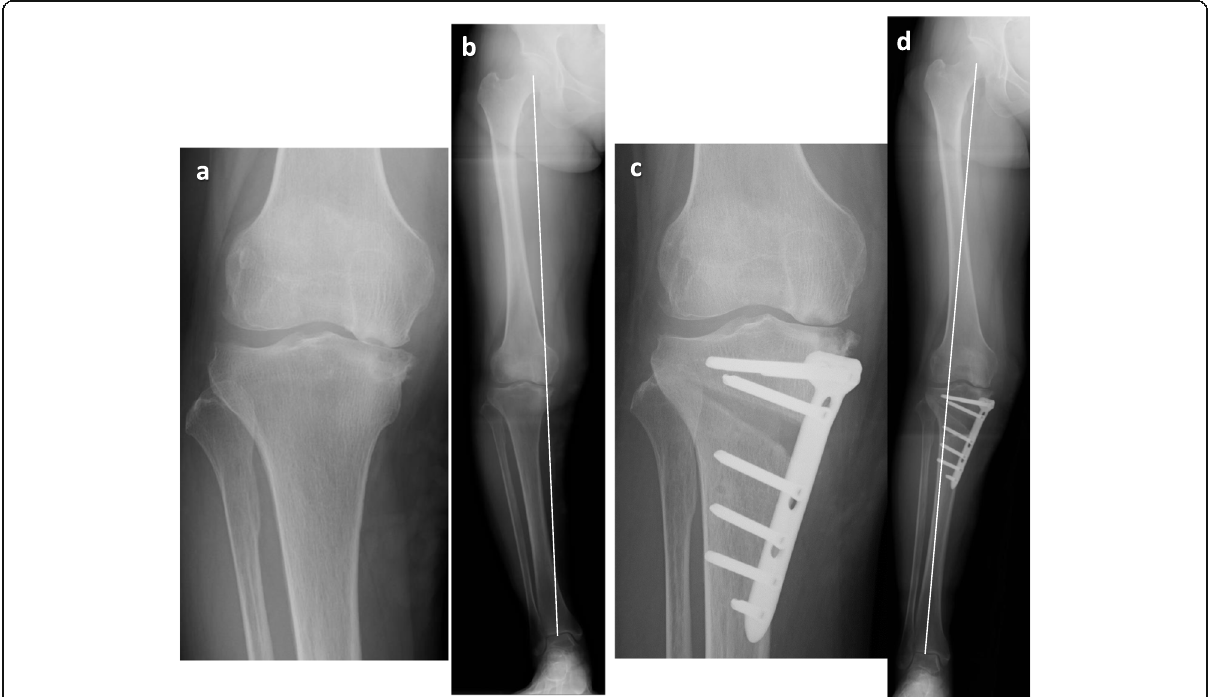
Fig. 2 A case of a 58-year-old woman with both femoral and tibial osteonecrosis. a Antero-posterior (AP) standing radiograph of the knee prior to surgery. Collapse of the medial tibial plateau and joint space narrowing was observed (Stage 4). b AP standing radiograph of the entire leg prior to surgery. The weight-bearing line ratio (WBLR) was 10.7%. The Oxford knee score was 30 points. c AP standing radiograph after OWHTO. d AP standing radiograph of the entire leg after OWHTO. The WBLR was 62.7%